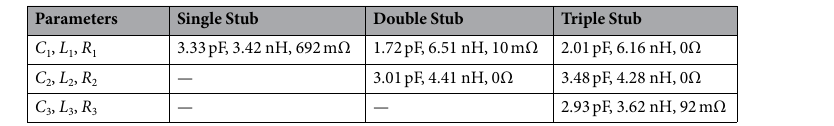
Table 2. The fitted RLC parameters generated by the Levenberg-Marquardt